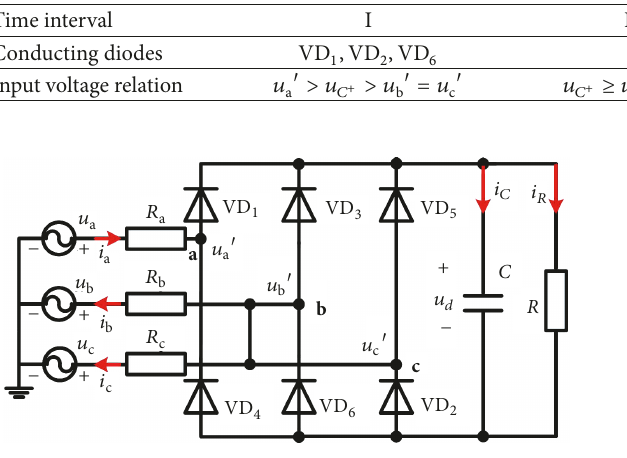
Figure 15: Three-phase bridge rectifier circuit running under interphase short-circuit condition.